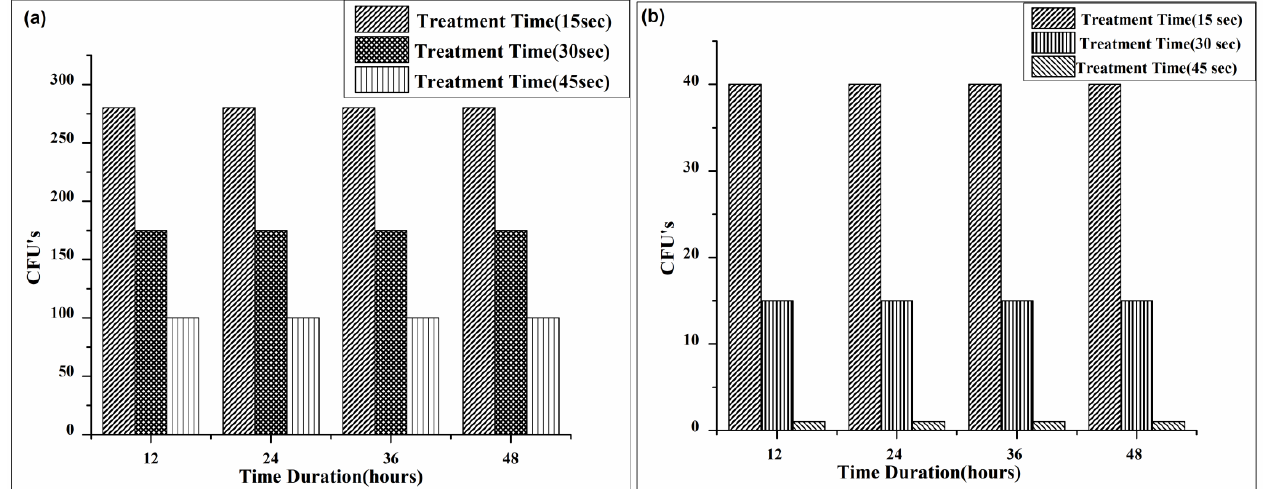
Figure 7. ( a ) Retardant effect without H 2 O 2 (0 m bar, 0 sccm); ( b ) retardant effect with H 2 O 2 (0.1 mbar, 5.9 sccm).